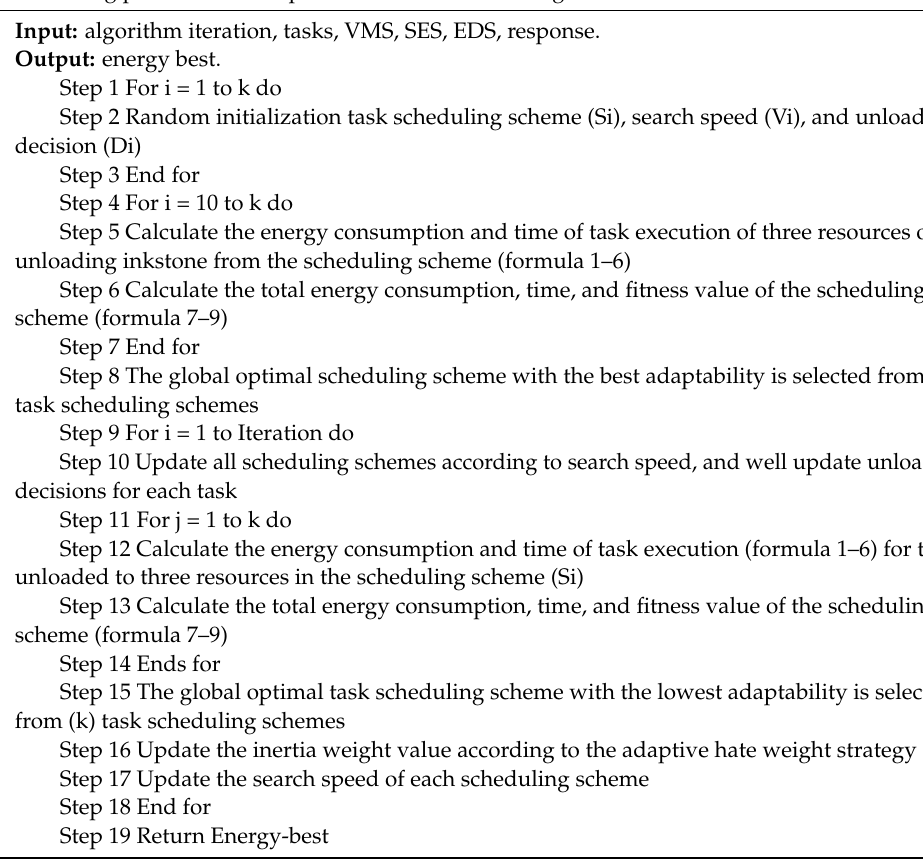
Algorithm 1: The energy consumption optimization algorithm for multi-resource computing and unloading particle swarm optimization task